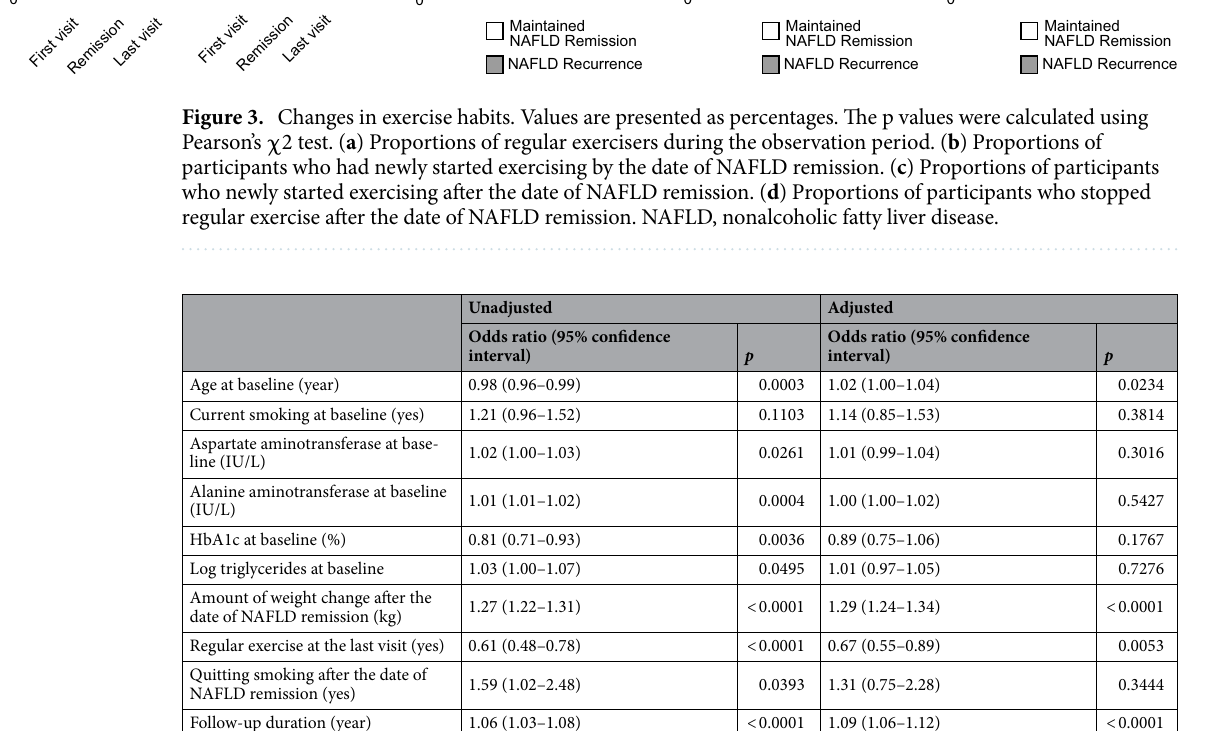
Table 2. Odds ratio of NAFLD recurrence in men.